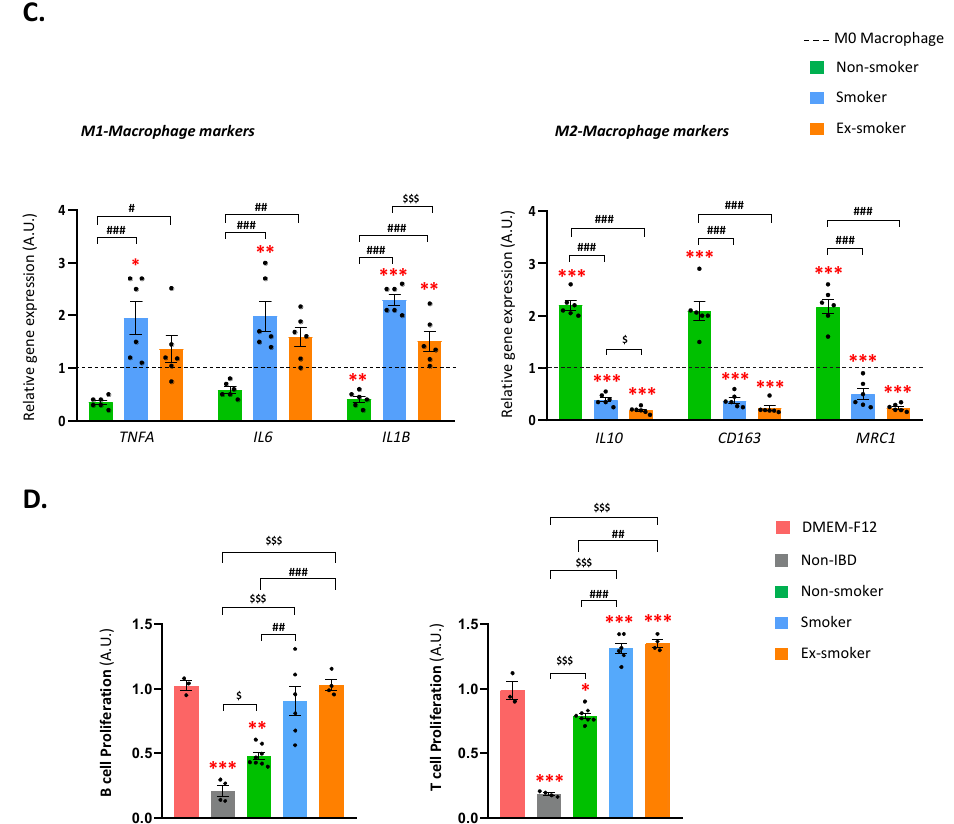
Figure 1. Adipose stem cells isolated from smokers and ex-smokers with Crohn’s disease have altered immunosuppressive properties. ( A ) Gene expression of pro-inflammatory genes ( TNFA , IL1B and CASP1 ) (left panel) and secretion levels of the pro-inflammatory cytokine IL1B (right panel) in SAT-derived adipose stem cells (ASCs) obtained from non-smokers, smokers or ex-smokers with Crohn’s disease. # p < 0.05; ## p < 0.01 vs. non-smoker group. ( B ) Gene expression of TGFB1 in ASCs obtained from non-smokers, smokers or ex-smokers with Crohn’s disease. ## p < 0.01; ### p < 0.001 vs. non-smoker group. ( C ) Gene expression of M1 macrophage markers ( TNFA , IL6 and IL1B ) (left panel) and M2 macrophage markers ( IL10 , CD163 and MRC1 ) (right panel) in THP-1 monocytes co-cultured or not (basal condition) with conditioned medium of ASCs obtained from non-smoker, smoker or ex-smoker patients with Crohn’s disease. * p < 0.05; ** p < 0.01; *** p < 0.001 vs. M0 macrophage (control). # p < 0.05; ## p < 0.01; ### p < 0.001 vs. non-smoker group. $ p < 0.05; $$$ p < 0.001 vs. smoker group. ( D ) Proliferation of B-cells (MEC-1 cell line) and T-cells (JURKAT cell line) co-cultured with conditioned medium of ASCs obtained from non-IBD subjects and from non-smoker, smoker and ex-smoker Crohn’s disease patients. * p < 0.05; ** p < 0.01; *** p < 0.001 vs. DMEM-F12 (control). ## p < 0.01; ### p < 0.001 vs. non-smoker group. $ p < 0.05; $$$ p < 0.001 vs. non-IBD group. Results are shown as mean ± SEM from independent donors’ experiments. Comparisons among the three groups were performed using two-way ANOVA followed with the Kruskal–Wallis